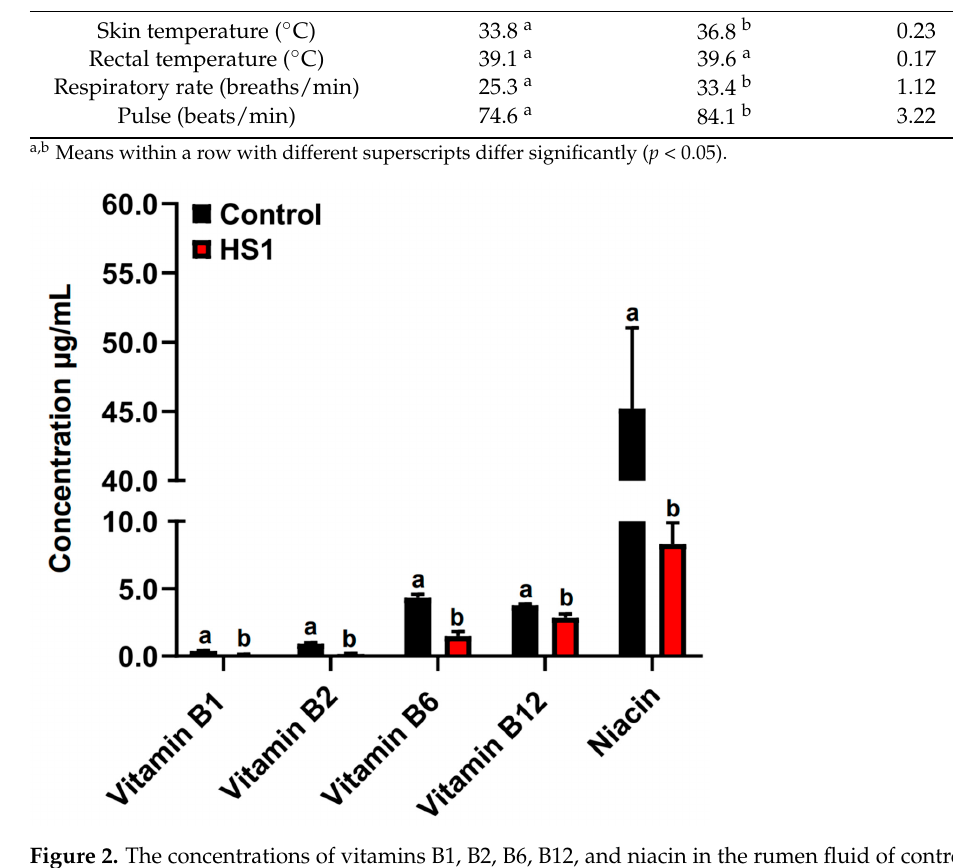
Figure 1. The expression of Hsp 70 genes and the concentrations of serum cortisol in goats. ( A ) The expression of HSPA 1, HSPA 6, and HSPA 8 genes in the blood lymphocytes of control and HS1. ( B ) The concentrations of serum cortisol of control and HS1. Data were analyzed using a two-tailed Student’s t -test and were considered statistically significant at * p < 0.05 and ** p < 0.01 between the control and HS1 groups. Data are expressed as the mean ± SEM. “ns” means not significant. Table 3. Influence of heat stress on the physiological parameters of goats. Parameters